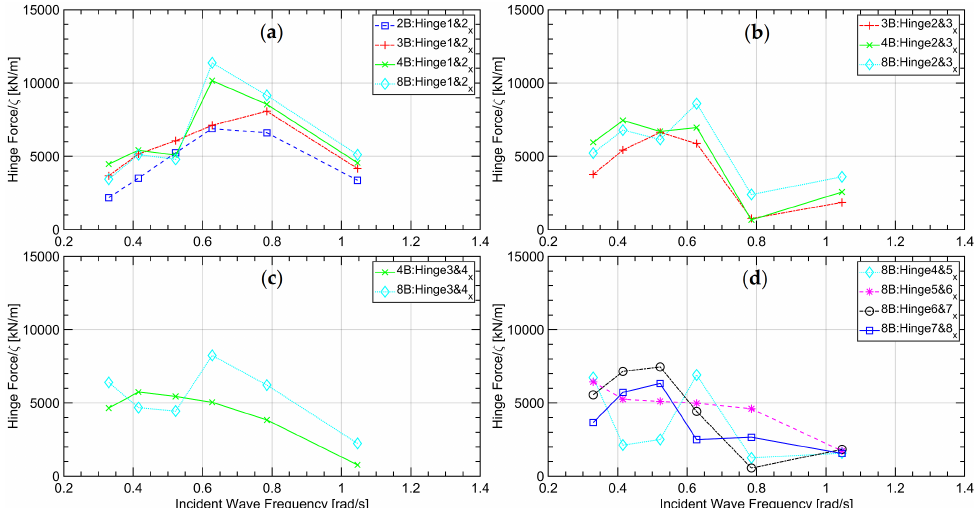
Figure 12. First-order hinge forces in horizontal direction of the five test cases for the chain configu- ration, where n B denotes the configuration with n bodies; m & n , the hinge connecting m -th body and n -th body; subscript x , the hinged forces in x direction: ( a ) between 1st and 2nd modules; ( b ) between 2nd and 3rd modules; ( c ) between 3rd and 4th modules; ( d ) between 4th and 5th , 5th and 6th , 6th and 7th , 7th and 8th